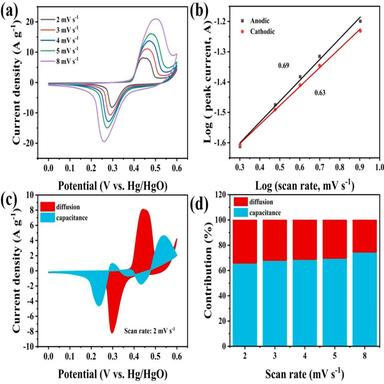
(a) CV curves scan at different rates of positive material MoO3 NWs @ PZSC / NiO; (b) log (i) vs. log (v) plots of MoO3 NWs @ PZSC / NiO; (c) capacitance and diffusion contribution curves at 2 mV s −1 of MoO3 NWs @ PZSC / NiO; (d) capacitance and diffusion contribution ratio at different scan rates.